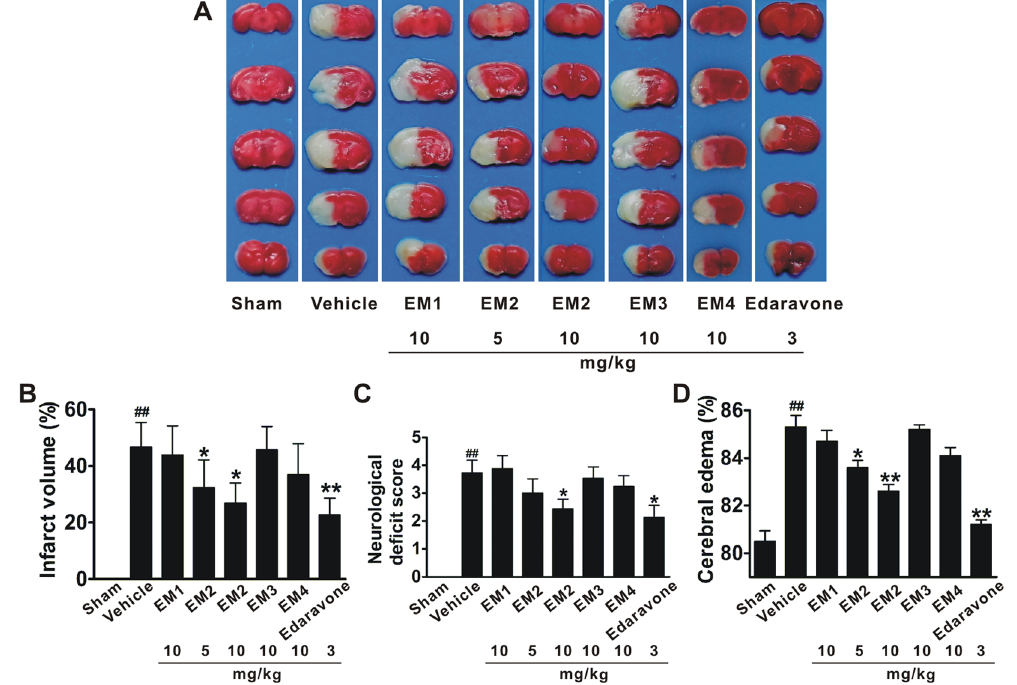
Figure 3. EphrinA1 mutants protect mice against I/R cerebral damage. ( A ) Representative TTC-stained brain coronal sections. Quantitative analysis of cerebral infarct volumes ( B ), neurological deficit scores ( C ), and cerebral edema ( D ). All data are presented as means ± S.E.M. (n = 10–12). ## p < 0.01 compared with sham group. * p < 0.05, ** p < 0.01 compared with vehicle